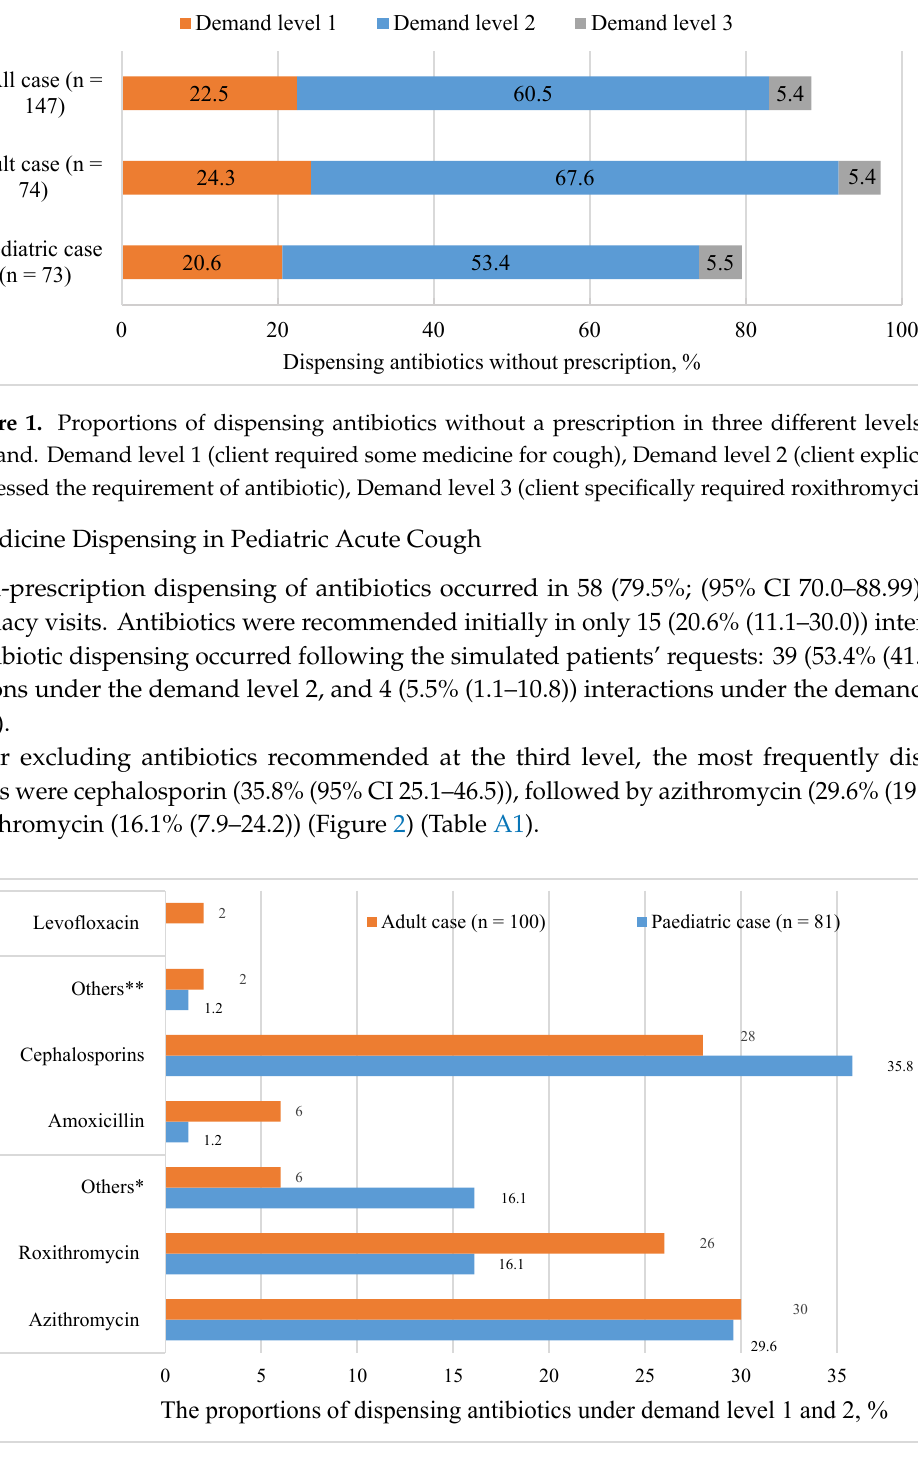
Figure 2. The proportions of dispensing antibiotics under demand levels 1 and 2. (n): the number of dispensed drugs; *: pediatric: cycloerythromycin (6), etoerythromycin (8); adult: roxithromycin ambroxol (5), erythromycin (1); **: pediatric: penicillin (1); adult: penicillin (1), amoxicillin clavulanate (1).